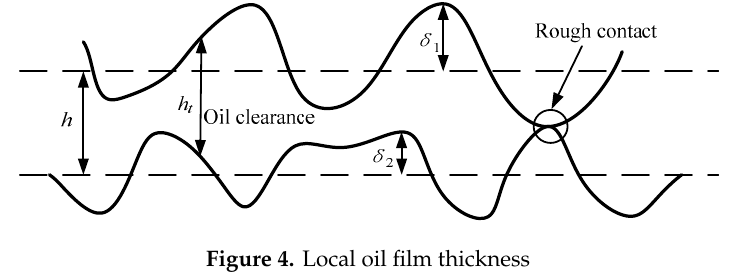
Figure 4. Local oil film thickness